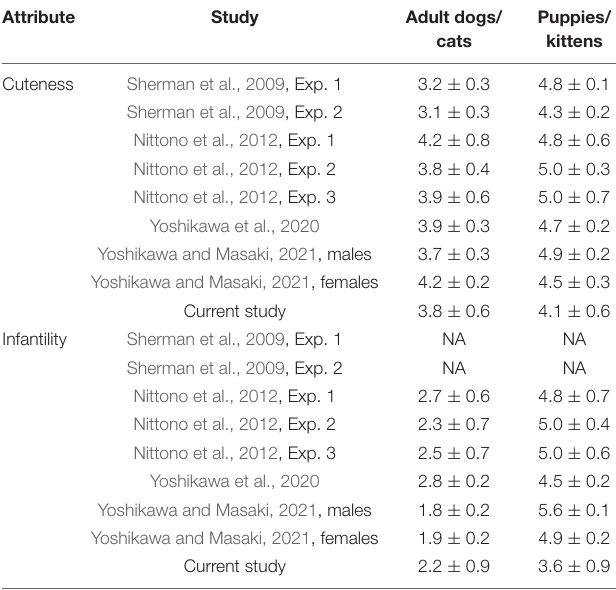
TABLE 3 | Comparison of ratings of cuteness and infantility in previous studies and in the current study (on a 6-point scale, either 0–5 or 1–6). Attribute Study Adult dogs/